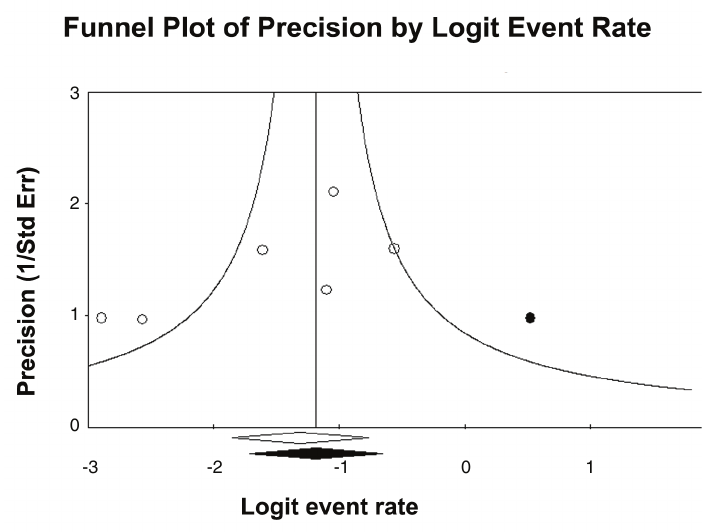
Figure 3. Funnel plot of precision by Logit Event Rate. This is a display of the study’s effect size on a logit scale against its precision for each study included in the meta-analysis. Egger’s test P = 0.047. Trim and Fill method showed close observed (20.7% with 95% CI 12.4 to 32.3%) and adjusted (22.7% with 95%CI 13.0 to 36.5%)